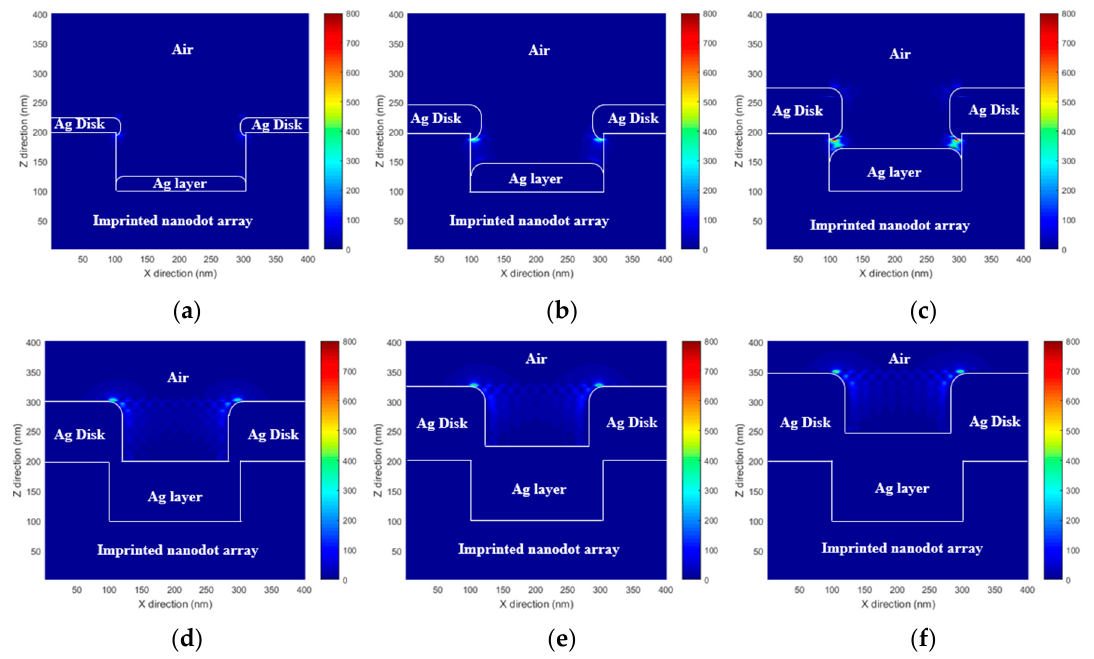
Figure 4. Simulated x – z plane ( y = 200 nm) electromagnetic field intensity distributions at the PNAA base plane of PNAA MEF substrates with Ag deposition thicknesses of ( a ) 25, ( b ) 50, ( c ) 75, ( d ) 100, ( e ) 125, and ( f ) 150 nm. The color bar represents the electromagnetic field intensity ( |𝐸| (cid:2870) ).